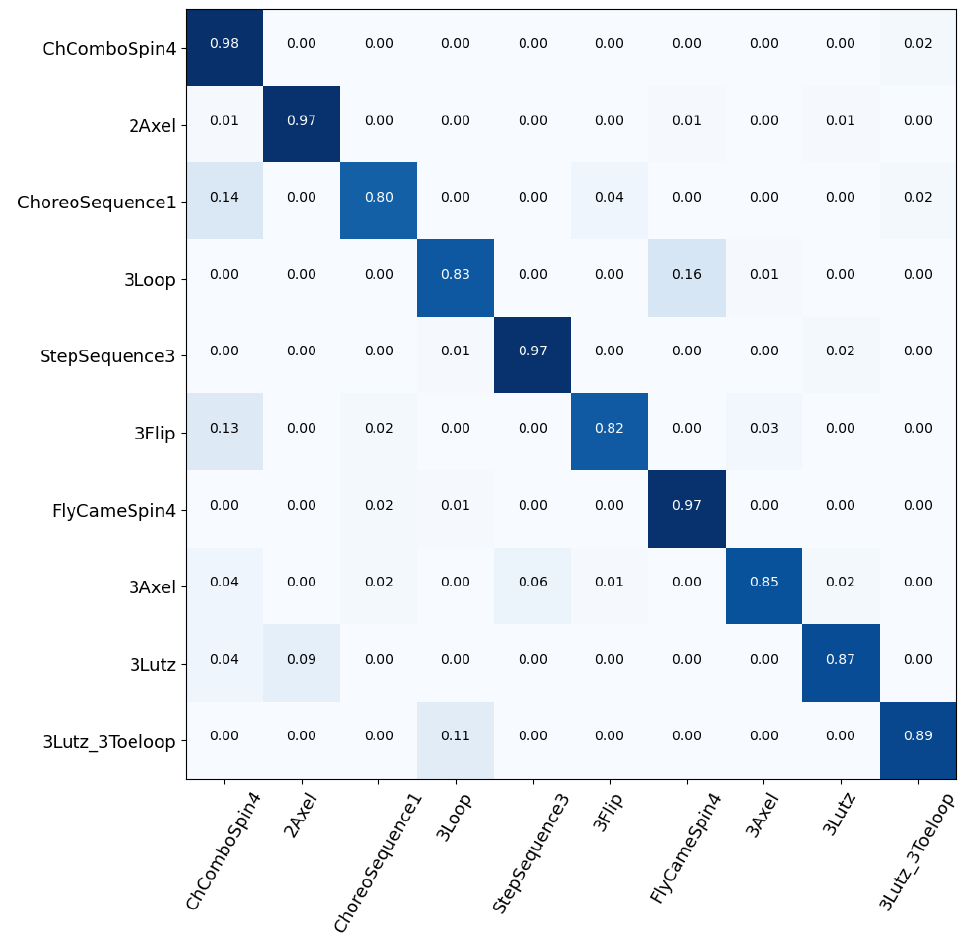
Figure 14. Confusion matrix results on FSD of our proposed model.